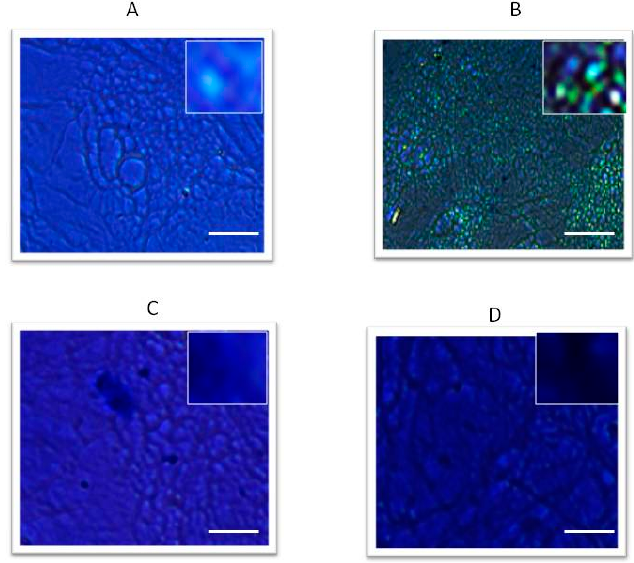
Figure 3. Alcian blue staining. After 21 days of culture, cells were fixed and stained with alcian blue in order to evaluate GAGs production. Control ( A ), cells treated with GFP nanoparticles alone ( B ); in the presence of IL β 1 ( C ); clodronate embedded NPs in the presence of IL β 1 ( D ). Scale bar 150 μ m; insert 80×.